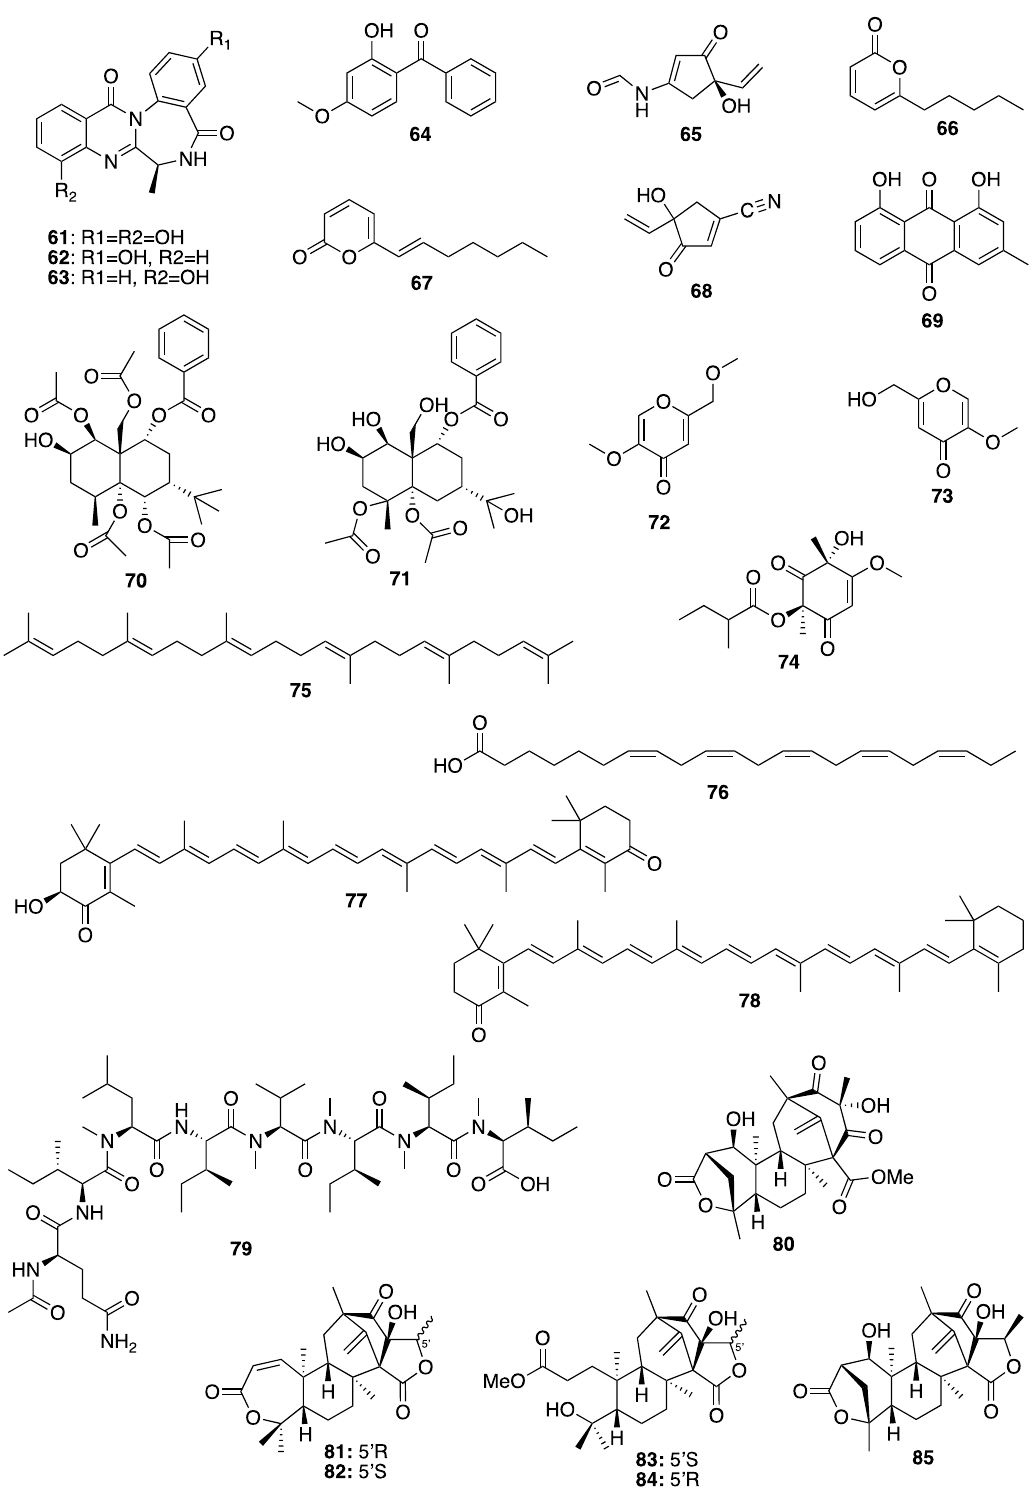
Figure 10. Structures of circumdatins I ( 61 ), C ( 62 ) and G ( 63 ), oxybenzone ( 64 ), myrothenone A ( 65 ), 6-n-pentyl- α -pyrone ( 66 ), 6-[(E)-hept-1-enyl]- α -pyrone ( 67 ), homothallin II ( 68 ), chrysophanol ( 69 ), 1 β , 5 α , 6 α , 14-tetraacetoxy-9 α -benzoyloxy-7 β H-eudesman-2 β , 11-diol ( 70 ), 4 α , 5 α -diacetoxy-9 α -benzoyloxy- 7 β H-eudesman-1 β , 2 β , 11, 14-tetraol ( 71 ), kojic acid dimethyl ether ( 72 ), kojic acid monomethyl ether ( 73 ), phomaligol A ( 74 ), squalene ( 75 ), docosapentaenoic ( 76 ), phoenicoxanthin ( 77 ), echinenone ( 78 ), RHM1 ( 79 ) and brasilianoids A – F ( 80–85 ). 3.3.4. Yeasts-Derived Compounds